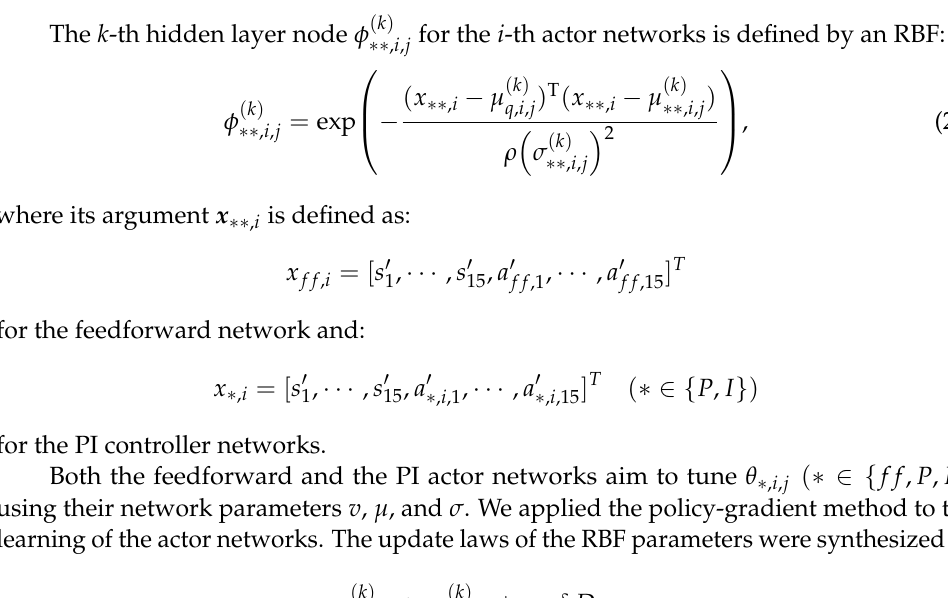
Figure 6. Actor networks for self-tuning controller parameters of the i -th manipulating device. We propose the structure ( A ) for feedforward control action and ( B ) for PI control actions. Both networks aim to maximize the expected reward by tuning the parameter θ ∗ , i , j ( ∗ ∈ { f f , P , I } ) . As θ ∗ , i , j are functions of their corresponding network parameters v , µ , and σ , we synthesized update rules for those parameters to achieve the